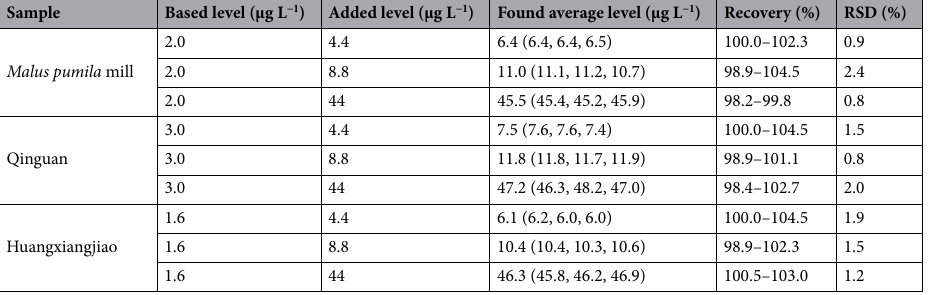
Table 1. Recovery values determination of abamectin B 1 in apple samples of the approach.